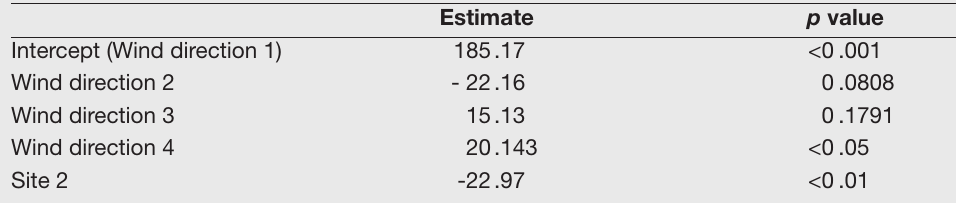
Table 1. Output from ANOVA showing individual probability ( p ) values for explanatory variables fitted as parametric terms, significant in explaining patterns of abundance in har- bour seals in Bantry Bay and Kenmare River during